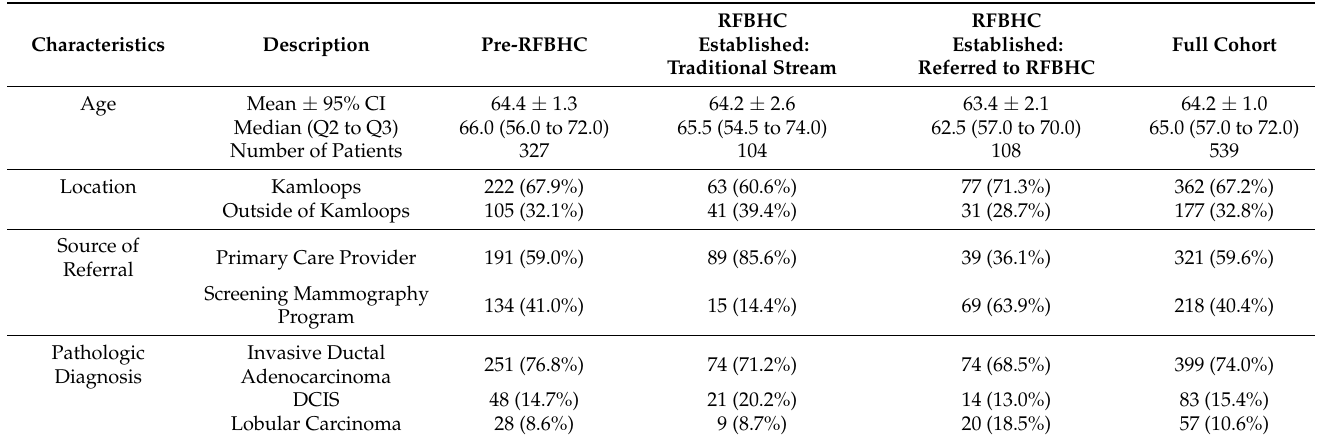
Table 2. Summary of study variables.